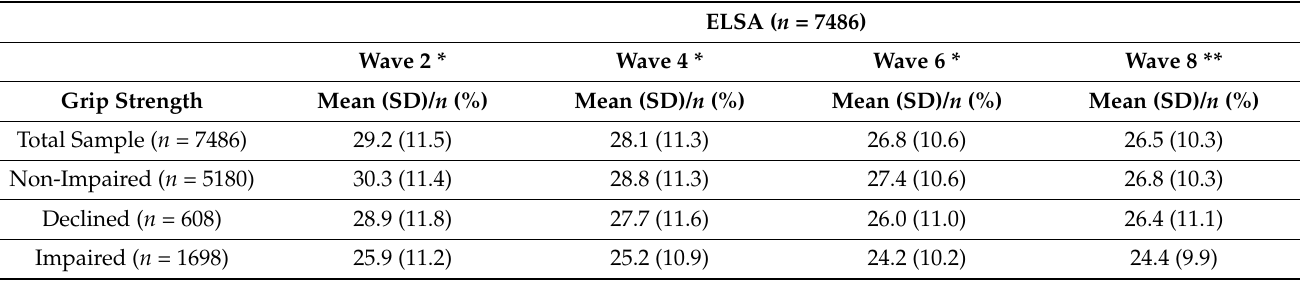
Table 2. Distribution of the physical functioning outcomes across different waves in ELSA cohort. ELSA ( n = 7486)